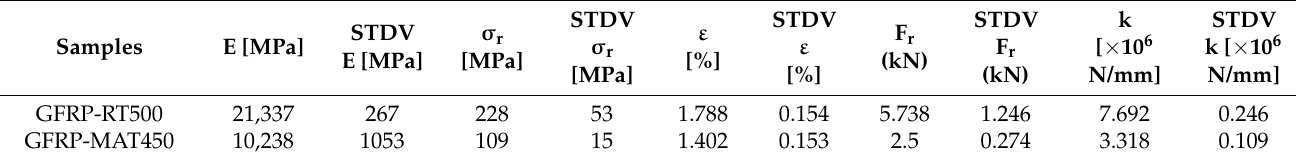
Table 4. Average values of elastic characteristics obtained after the tensile test. Legend: E—longitudinal elasticity modulus; σ r —the rupture strength; ε —percentage strain at maximum load; F r —load at break; k—stiffness.